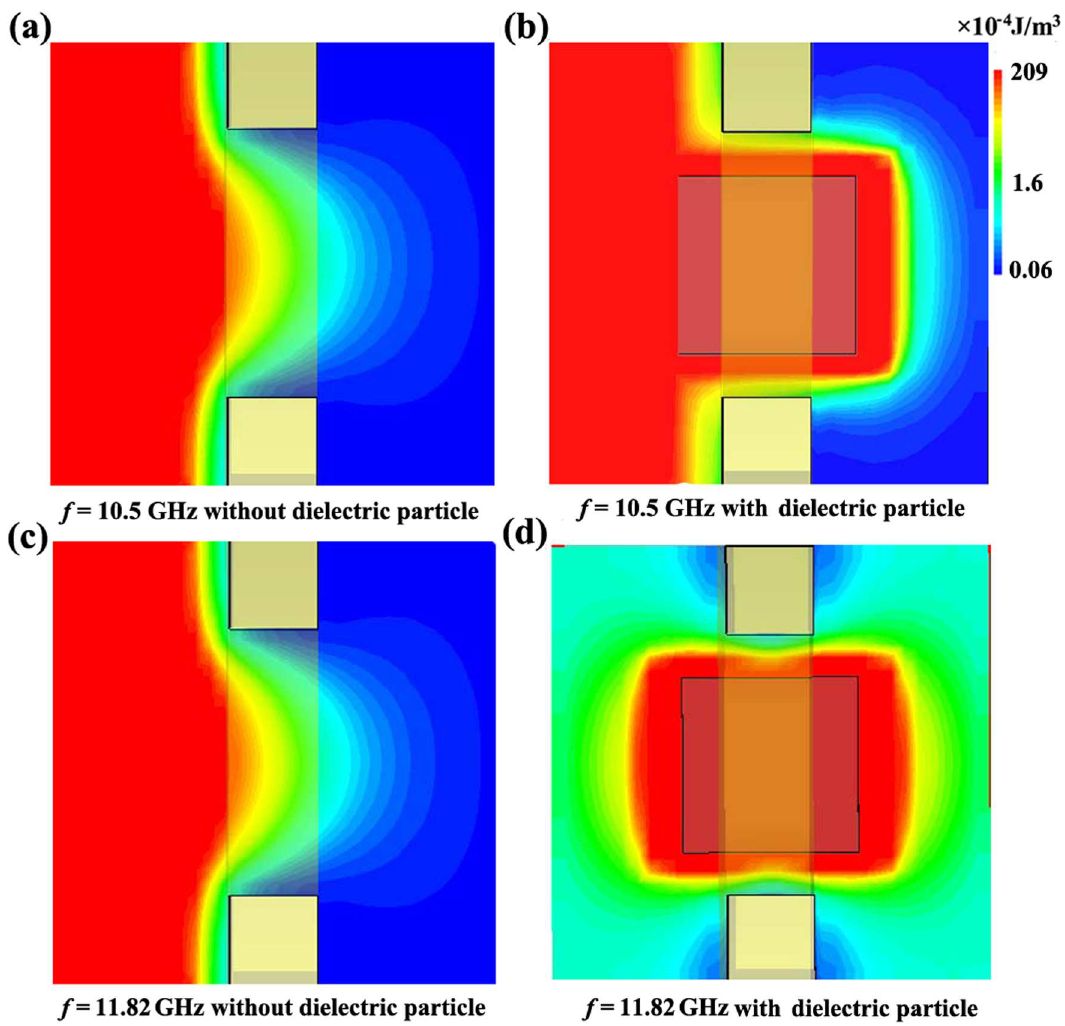
Fig 4. Simulated electric energy density distribution in the xy -plane. (A) Simulated electric energy density distribution in the xy -planefor metallic apertureunit cell at 10.5 GHz; (B) Simulated electric energy density distributionsfor microwave filter unit cell at 10.5 GHz when l = 2.0 mm; (C) Simulatedelectric energy density distribution for metallic apertureunit cell at 11.82 GHz; (D) Simulated electric energydensity distributionsfor microwave filter unit cell at 11.82 GHz when l = 2.0